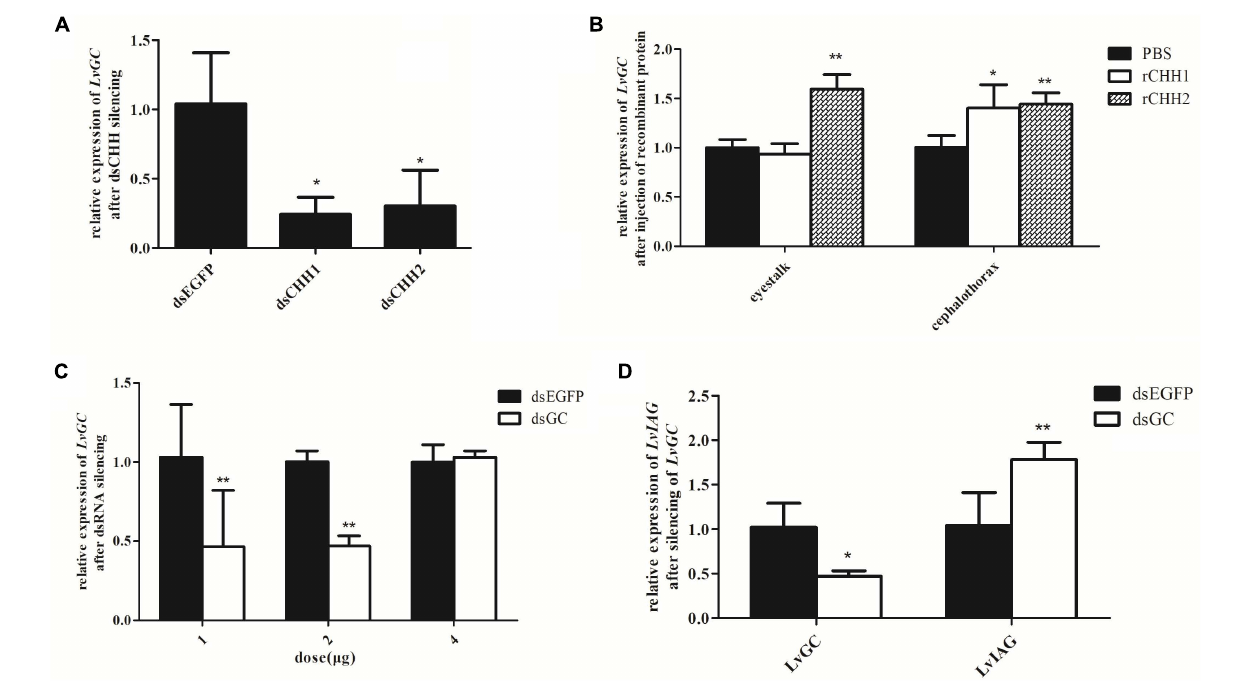
FIGURE 8 | Expression relationships among LvGC, LvCHHs, and LvIAG. Expression levels of LvGC after LvCHHs knockdown or recombinant protein injection. (A) The expression level of LvGC after LvCHHs knockdown. dsEGFP, injected with dsEGFP; dsCHH1, injected with dsCHH1; dsCHH2, injected with dsCHH2. (B) The expression level of LvGC after injection with rCHHs. (C) Silencing efficiency on LvGC using different dosage of dsRNA. (D) Expression changes of LvIAG after LvGC knockdown. PBS, injected with PBS; rCHH1, injected with rCHH1; rCHH2, injected with rCHH2; dsEGFP, injected with dsEGFP; dsGC, injected with dsGC. Expression levels of target genes were detected in three replicates. Significant differences of the gene expression levels between two treatments were shown with a star ( ∗ ) at P < 0.05 or two stars ( ∗∗ ) at P < 0.01.